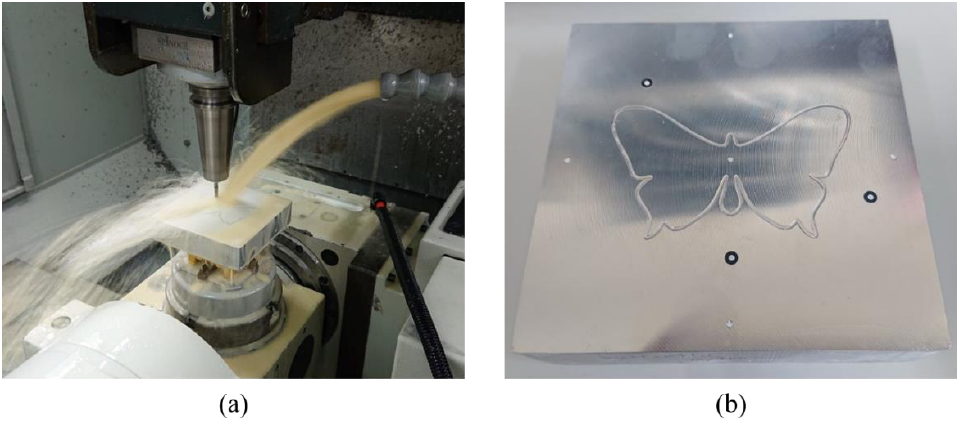
Figure 10. ( a ) Curvature and ( b ) curvature variation of butterfly shape.